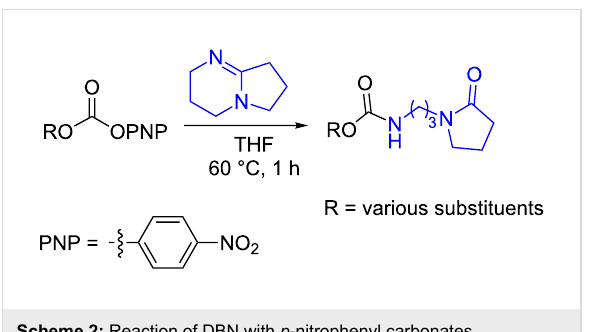
Scheme 2: Reaction of DBN with p -nitrophenyl